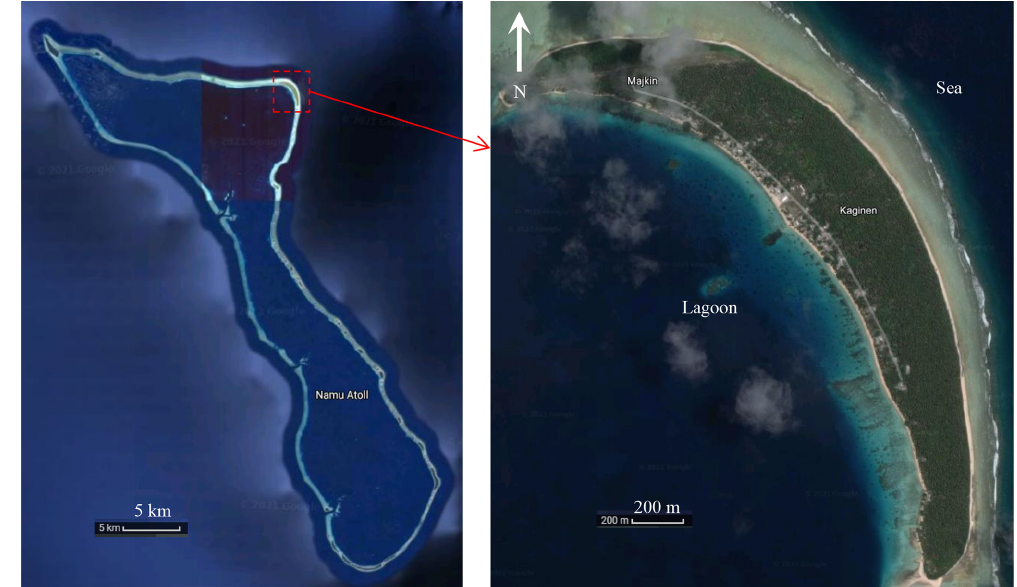
Figure 1. Island with an annulus segment in the Namu Atoll, Marshall Islands (© Google Earth